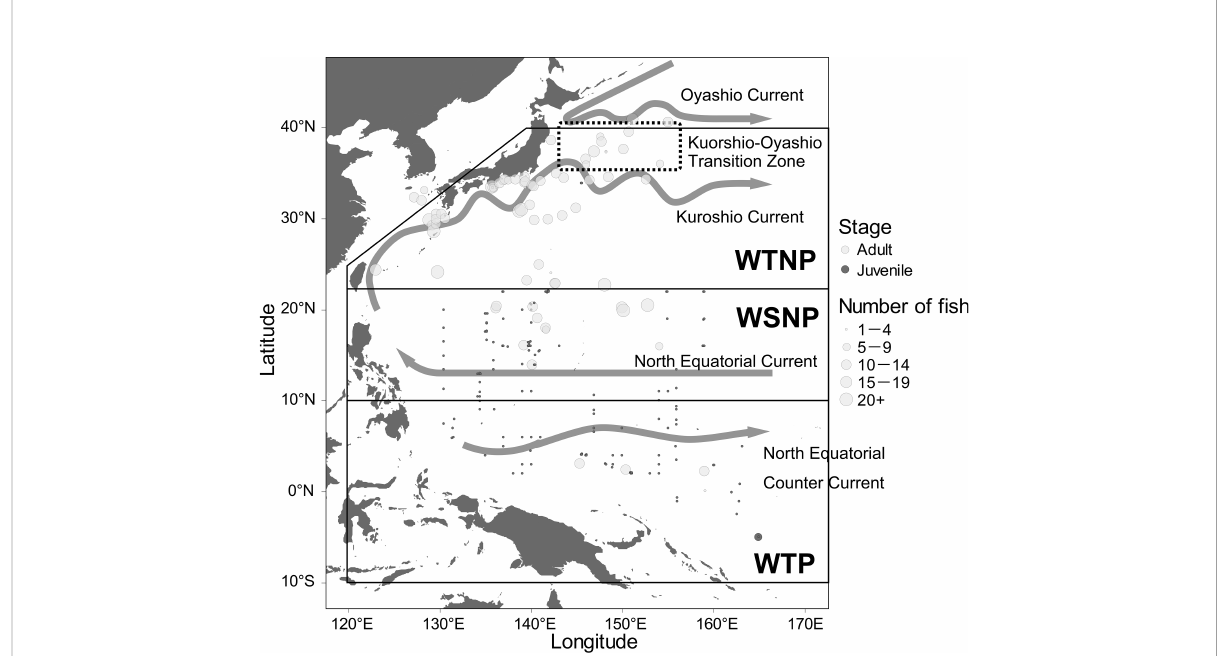
FIGURE 1 Sampling points and sample sizes of juvenile and adult skipjack tuna ( Katsuwonus pelamis ), boundaries of the western tropical Paci fi c (WTP), western subtropical North Paci fi c (WSNP), western temperate North Paci fi c (WTNP), and schematic diagram of the major currents in the western Paci fi c Ocean. The Kuroshio-Oyashio Transition Zone is known to have high net primary productivity (Nishikawa et al.,